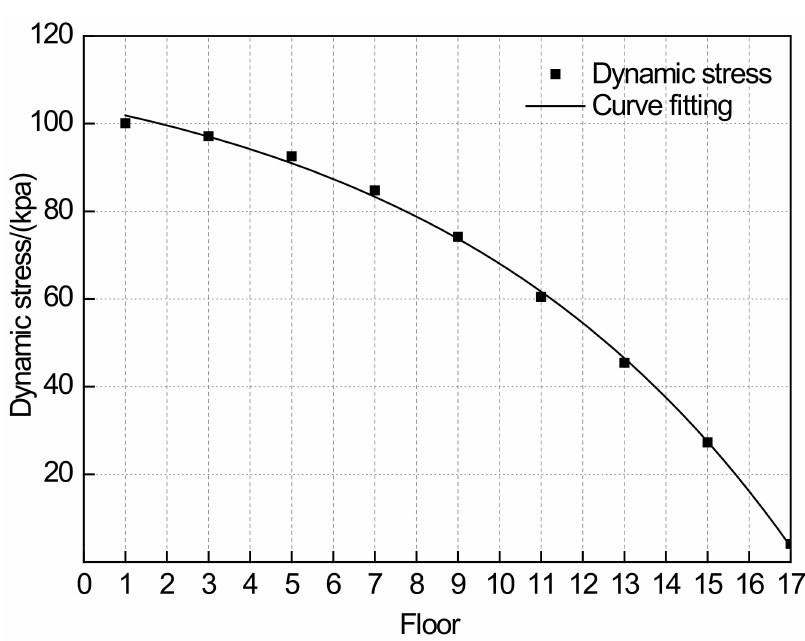
Figure 9. Relationship between dynamic stress and